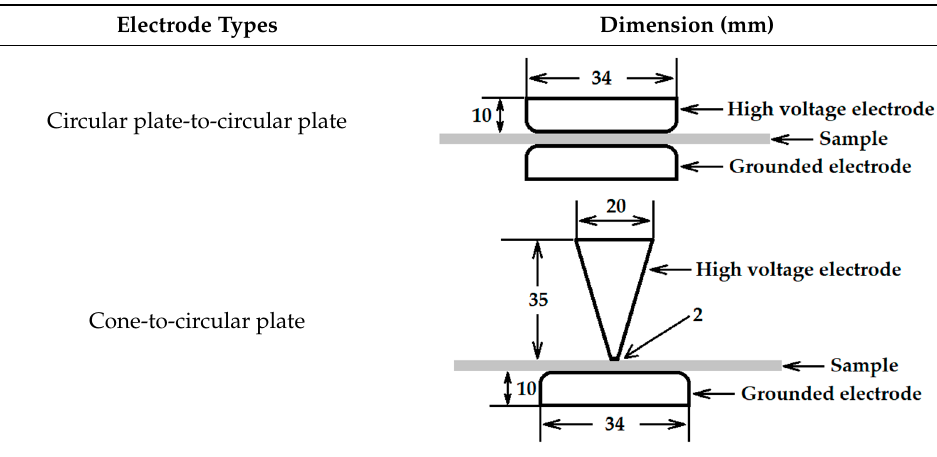
Table 1. Parameters of the electrodes.